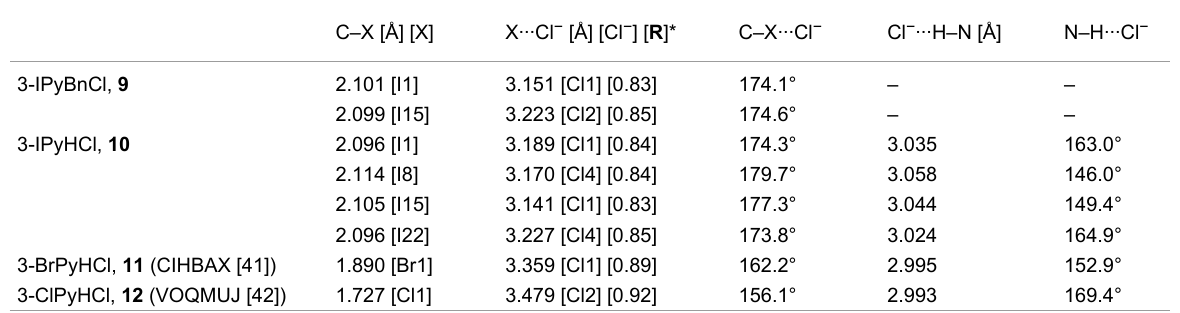
Table 4: Relevant covalent bond, hydrogen bond and halogen bond lengths and angles in 9 – 12